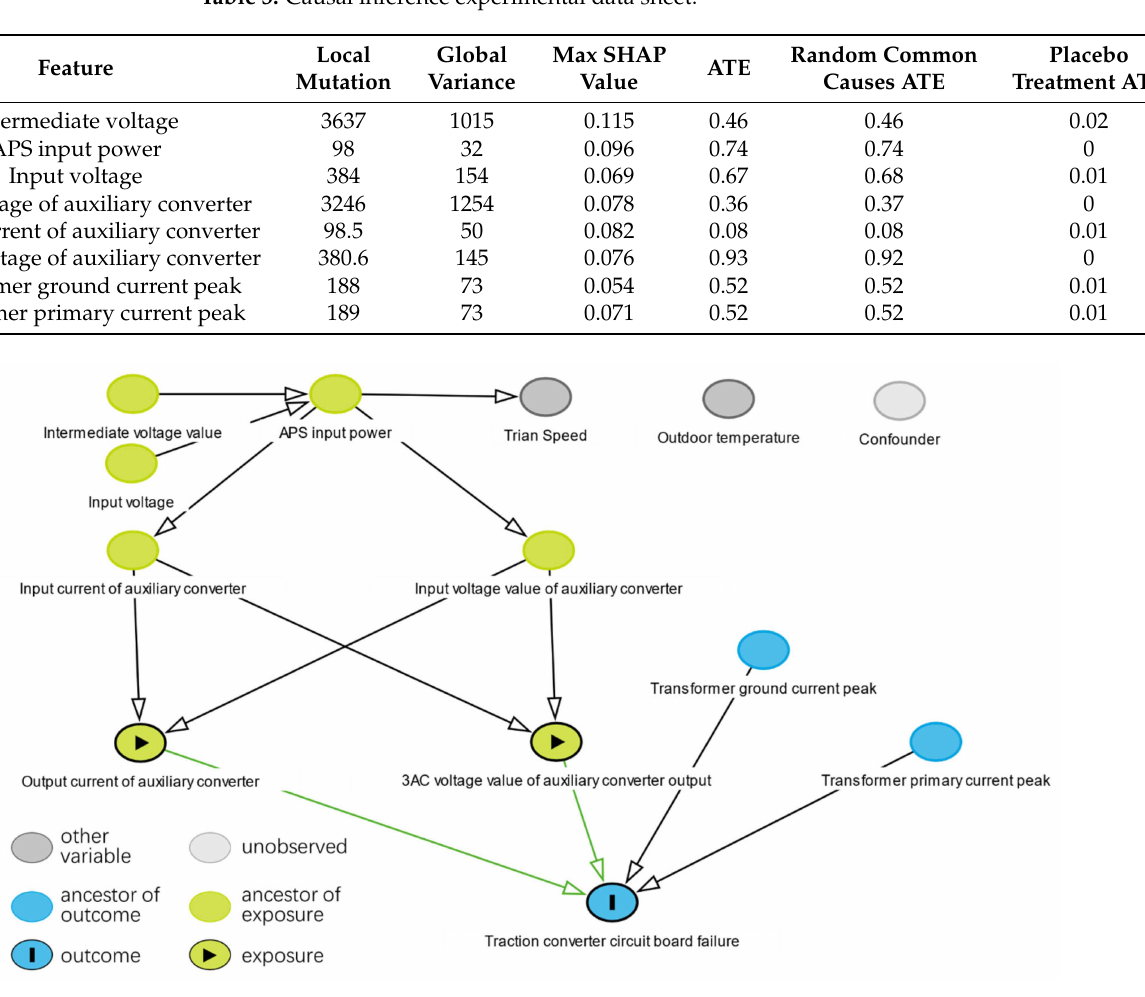
Figure 9. Feature causal inference graph of traction converter circuit board